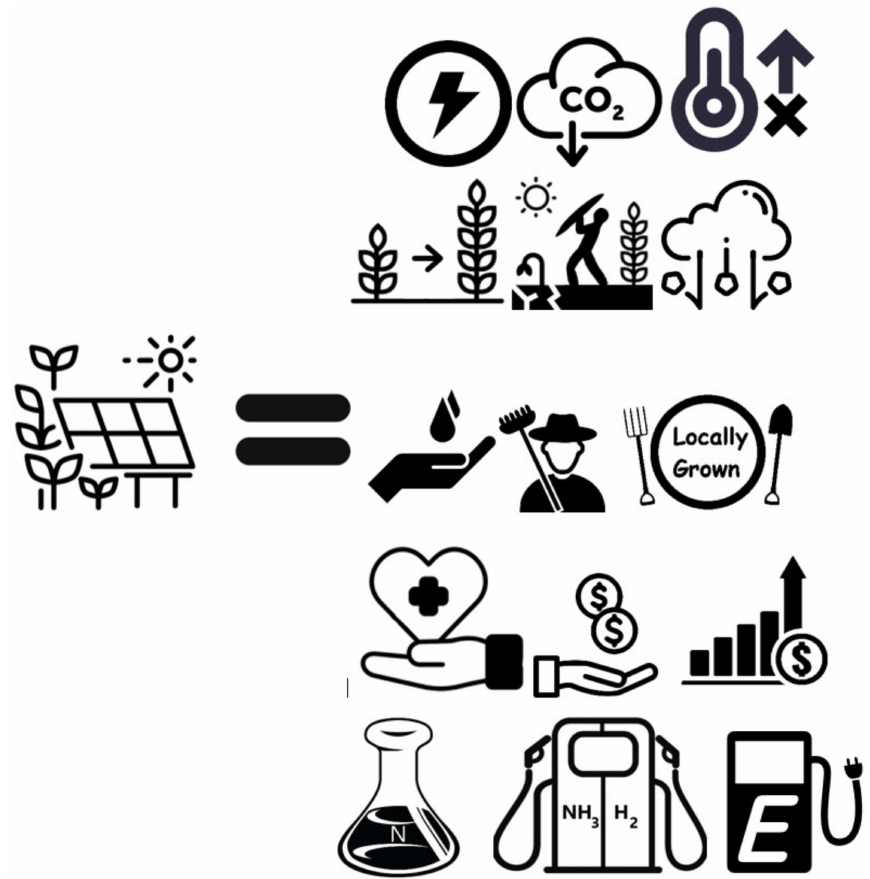
Figure 1. Services provided by agrivoltaics are: renewable electricity generation, decreased green- house gas emissions, reduced climate change, increased crop yield, plant protection from excess solar energy, plant protection from inclement weather such as hail, water conservation, agricultural employment, local food, improved health from pollution reduction increased revenue for farmers, a hedge against inflation, the potential to produce nitrogen fertilizer on farm, on farm production of renewable fuels such as anhydrous ammonia or hydrogen, and electricity for EV charging for on- or off-farm